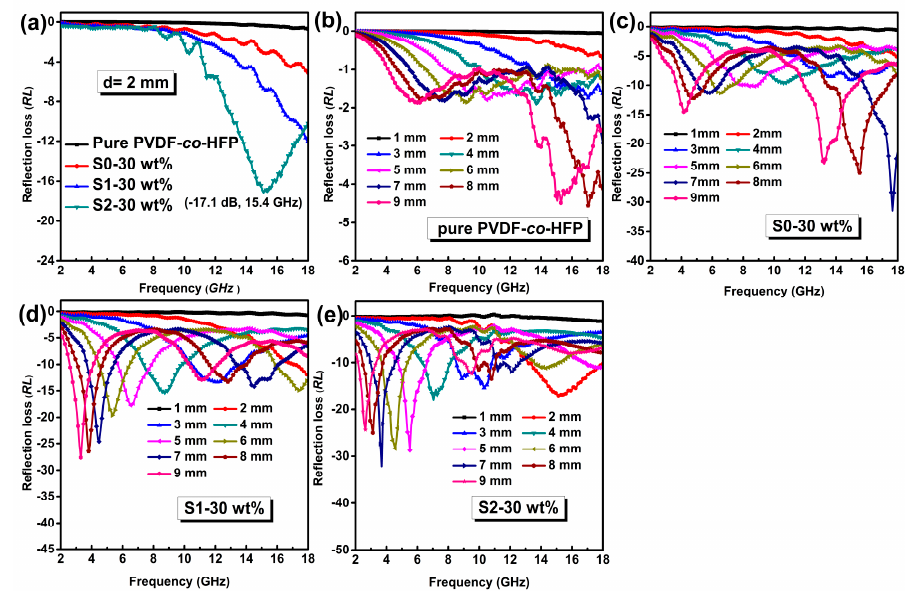
Figure 6. Frequency dependence of the calculated RL values of all the samples in the range of 2–18 GHz: ( a ) the thickness of 2 mm, ( b-e ) at different thickness.